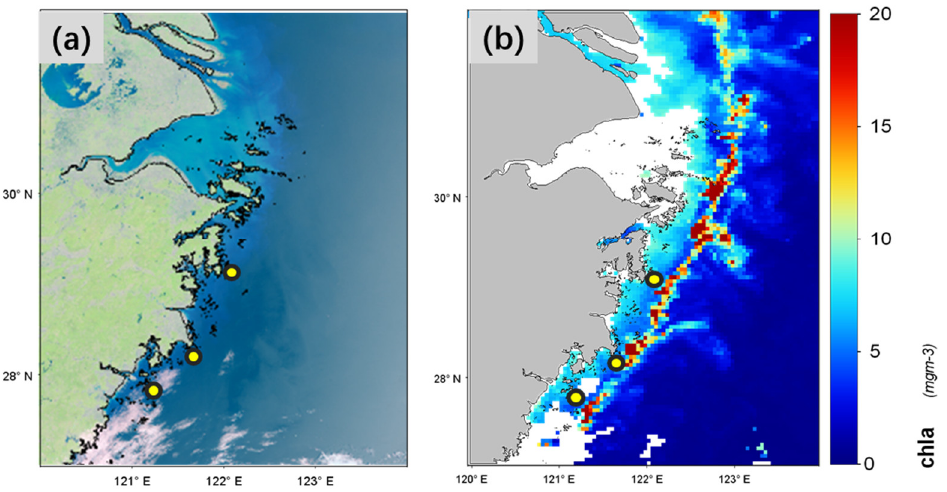
Figure 6. SGLI images of ( a ) false RGB image and ( b ) satellite Chl-a map on 29 April 2020. The highlighted circles indicate the location of Prorocentrum donghaiense blooms.